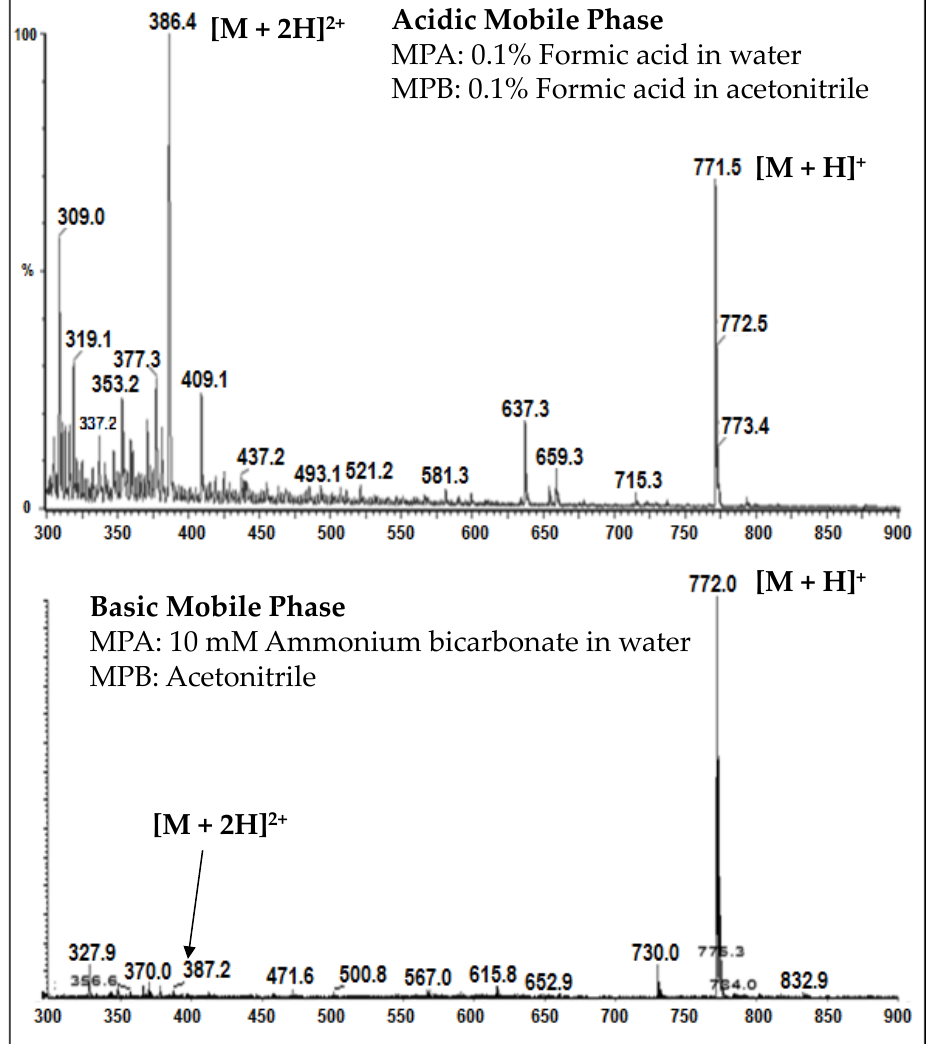
Figure 7. Charge-state distribution of AZ13599185 in acidic and basic mobile